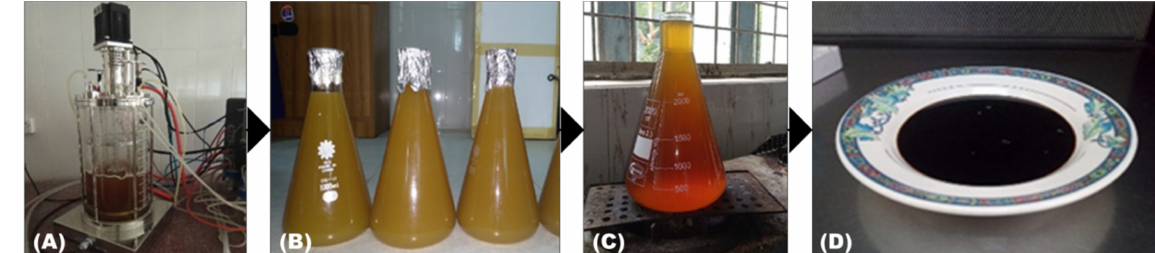
Figure 6. Pigment extraction produced by Aspergillus niger . ( A ) Fermentation by Aspergillus niger ; ( B ) filtrate after fermenta- tion; ( C ) heat treatment of the filtrate; ( D ) final product found after rotary evaporation.